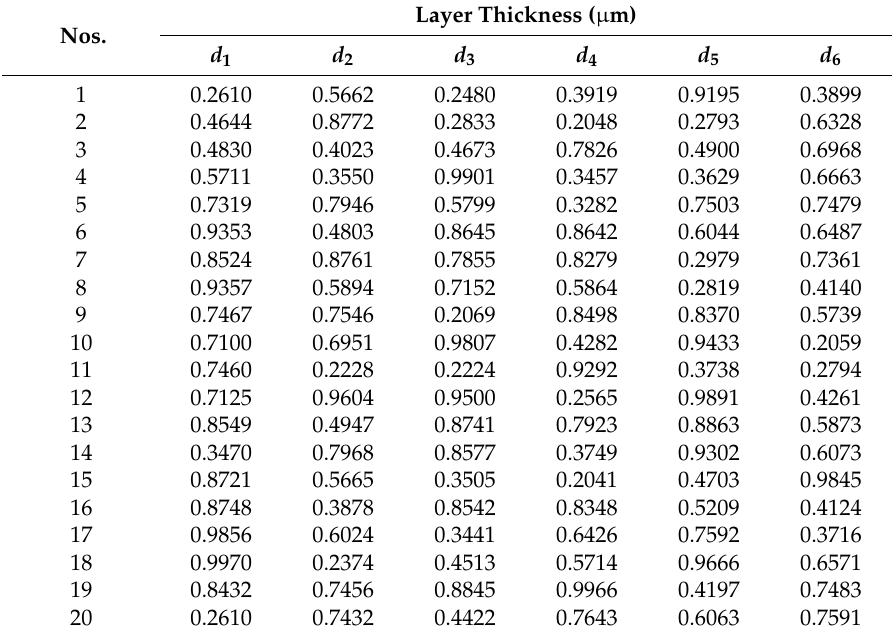
Table 4. 20 groups of layer thicknesses used in the testing.